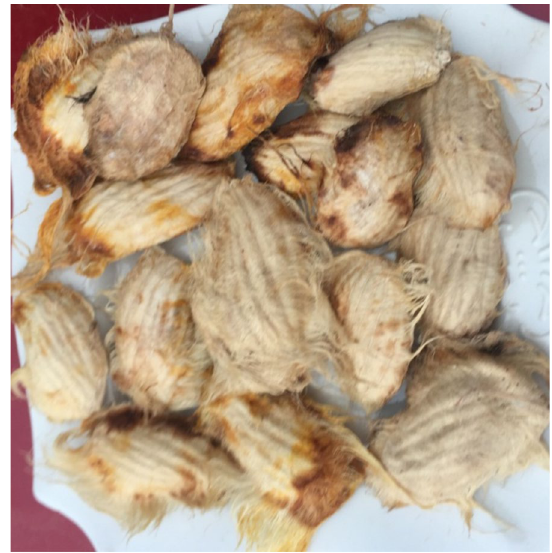
Fig. 7 Mangifera indica seed kernels. Size: 85 mm by 83.8 mm. Source: Mojisola